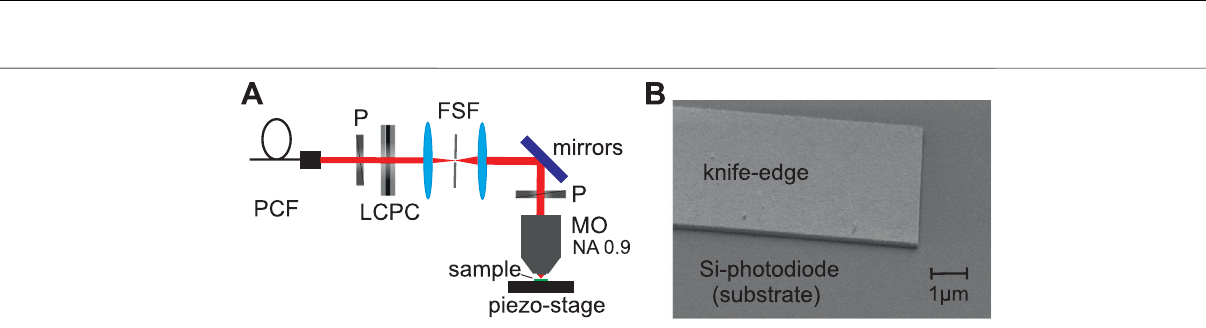
Frontiers in Physics |